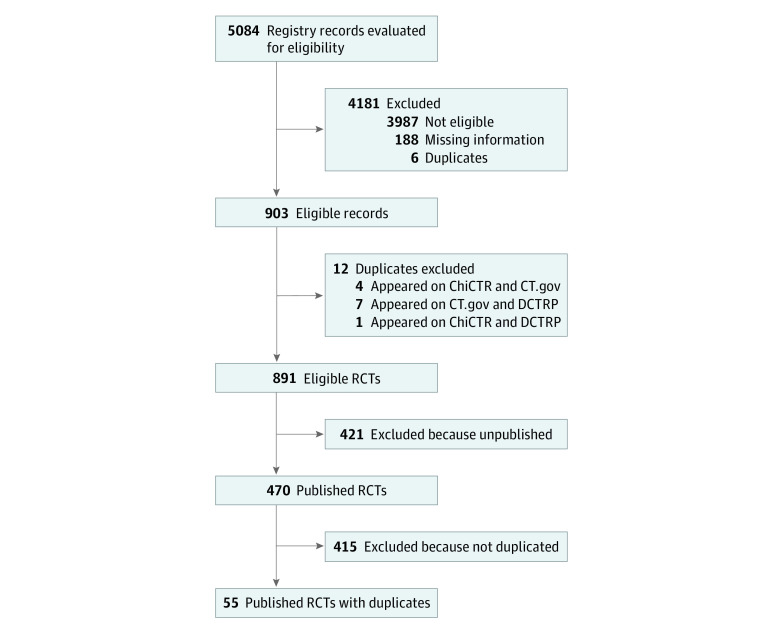
Study Flowchart Identifying Chinese-Sponsored Randomized Clinical Trials With DuplicatesChiCTR indicates Chinese Clinical Trial Registry; CT.gov, ClinicalTrials.gov; DCTRP, Drug Clinical Trial Registry Platform.